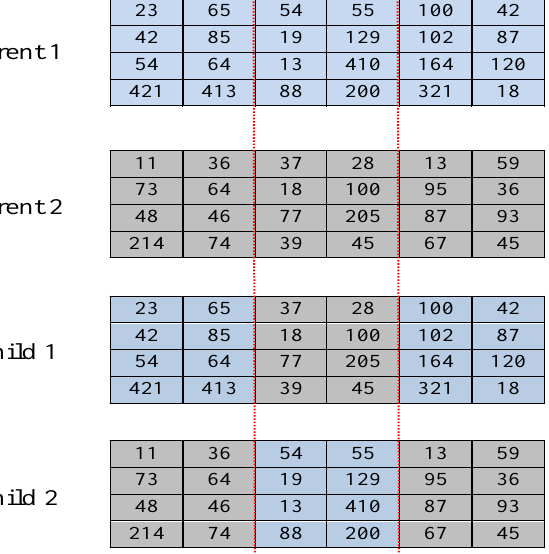
Fig. 2. Two-point intersection operator.